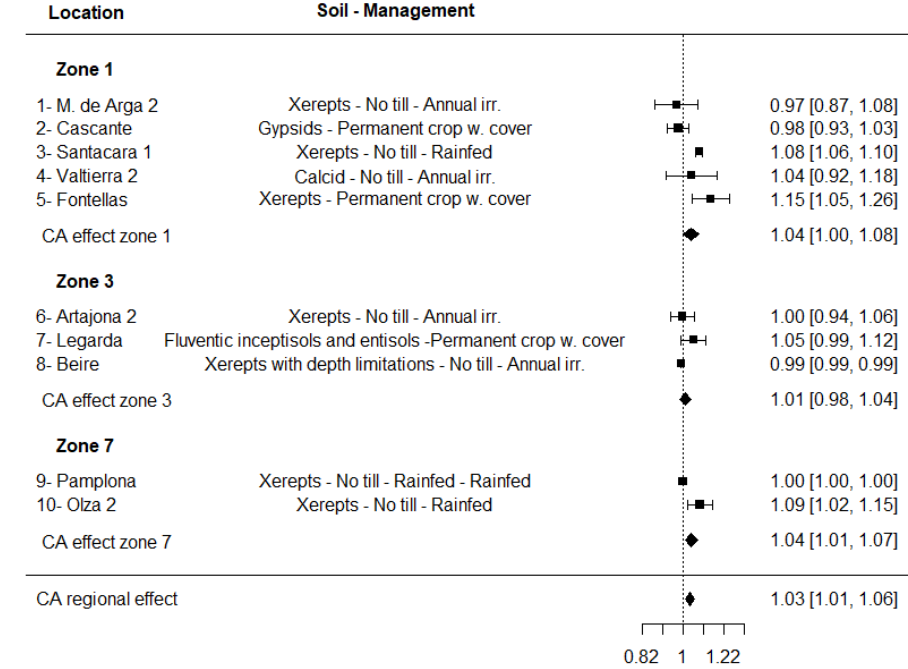
Figure 6. Response ratio (RR) of BD (0–30 cm) for the adaptive management strategy of conservation agriculture (CA). Zones correspond to those in Figure 1. The effect was considered significant when the 95% confidence interval (CI) of the RR did not overlap one ( α = 0.05). Soil and management column includes information about principal soil group, strategic management considered and irrigation regime in each group.